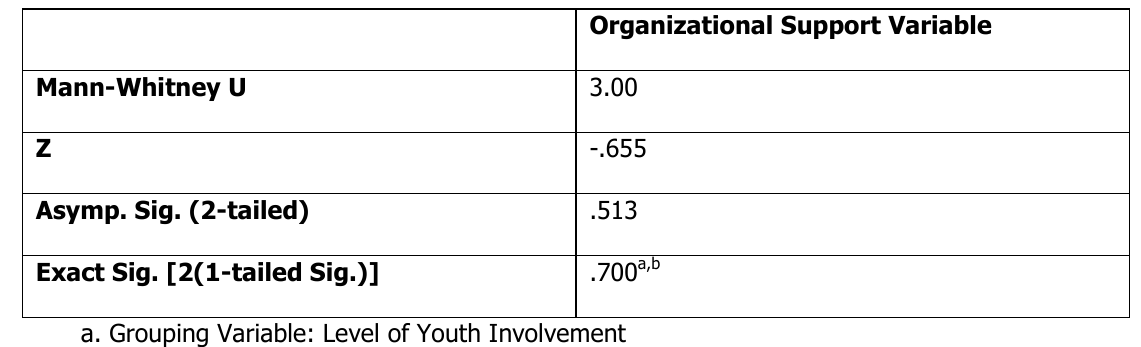
Mann Whitney U 2-sample test (normal approximation) to compare organizations with high (n=3) and low levels of youth involvement (n=3) with the outcome variable of organizational support for LGBT adolescents, Alachua County, Florida,